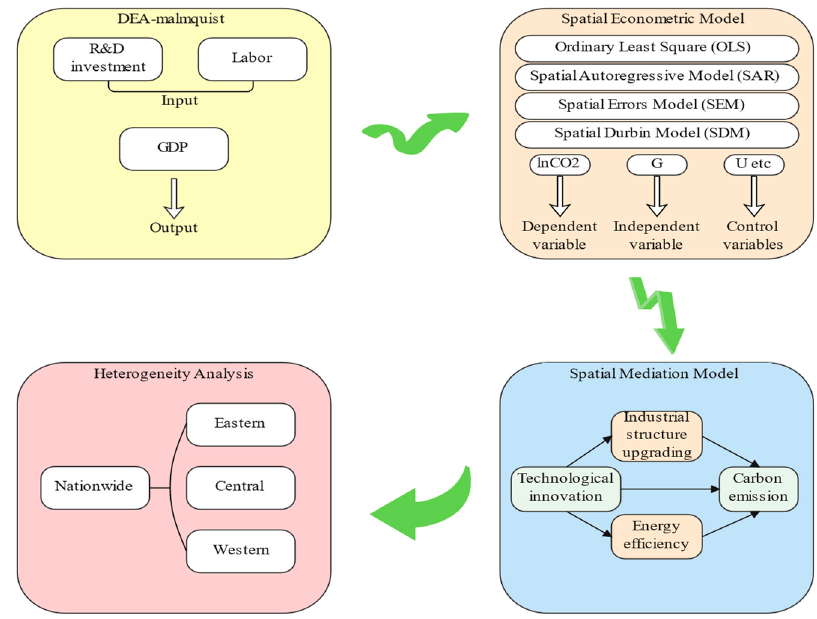
Figure 1. Analysis Figure 1. Analysis framework.